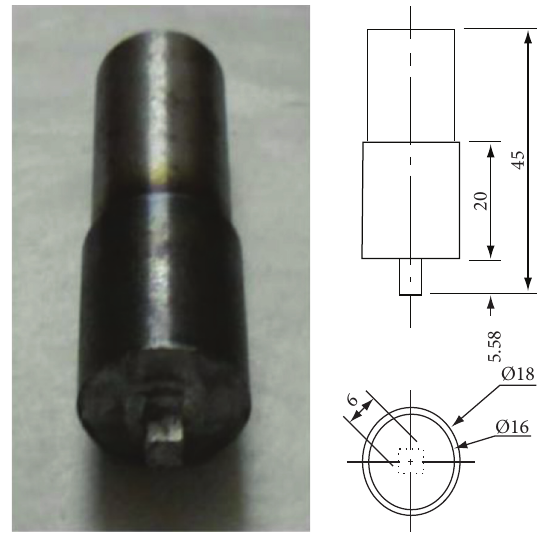
Figure 3: HC steel FSP tool and its geometric